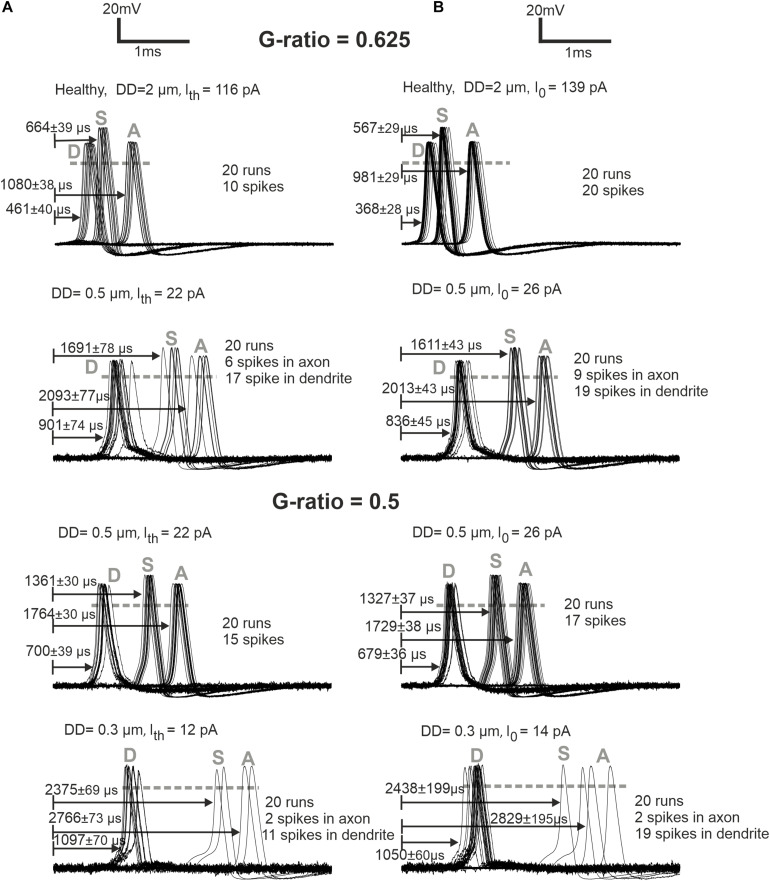
ANF responses at dendrite (first compartment), soma, and axon (last compartment) are marked with D, S, and A, respectively. (A) Later APs and larger jitters for synaptic stimuli at threshold (Ith) versus (B) more synchronized responses for synaptic stimuli at I0 = 1.2 × threshold are represented for G-ratios = 0.625 and 0.5. While the arrows start at the stimuli onset, the delays represent the time when the membrane voltage reaches 0 mV (shown with gray dashed horizontal lines). Recording point A of simulations corresponds with the axonal terminal from the micro-CT sample (Potrusil et al., 2020).